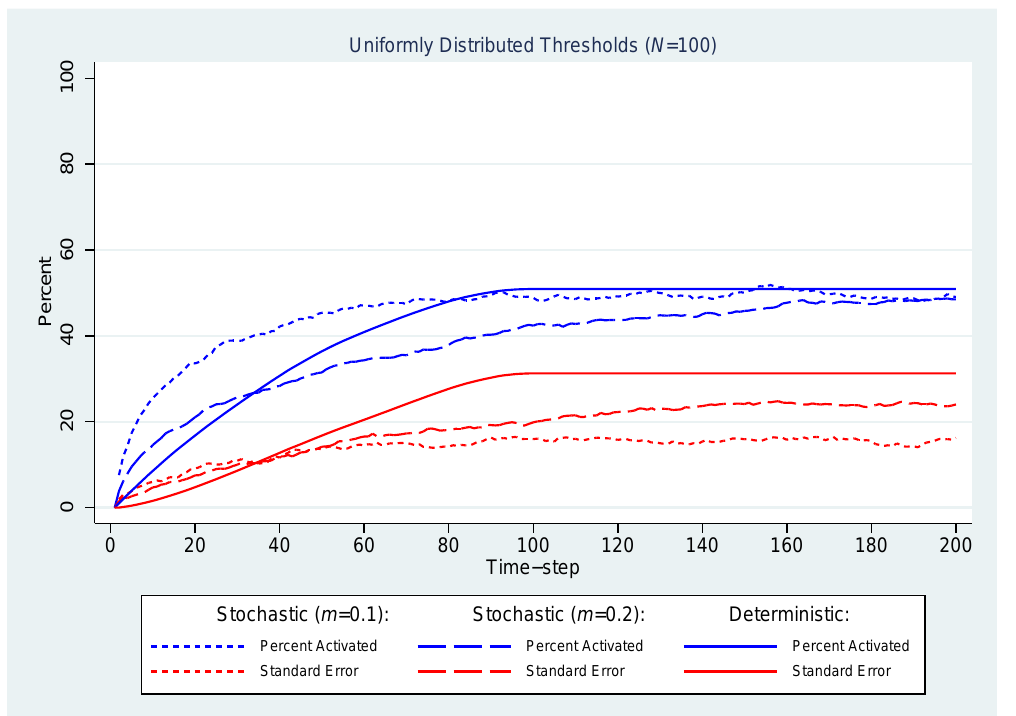
Figure 2: Unpredictability of activation level with a uniform threshold distribution and uniform random perturbations. The blue lines report the mean percentage activated in groups with N = 100 members. The red lines measure unpredictability as the observed standard error, that is, the standard deviation of the distribution of sample means over 100 observed distributions, each with a randomly located perturbation. Results show that as noise is added to individual behavior (going from the dashed lines with m = 0.2 to the dotted lines with m = 0.1), activation errors overwhelm the effects of random perturbation in the distribution of thresholds. With deterministic thresholds, cascade outcomes are uniformly distributed, reflecting the distribution of perturbations. With stochastic thresholds, the outcomes converge toward a normal distribution with a slight decline in the mean level of activation, but the mean becomes a modestly better predictor of particular